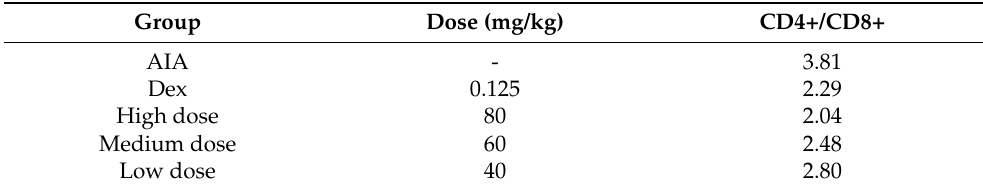
Table 1. The ratio of CD4+/CD8+ of